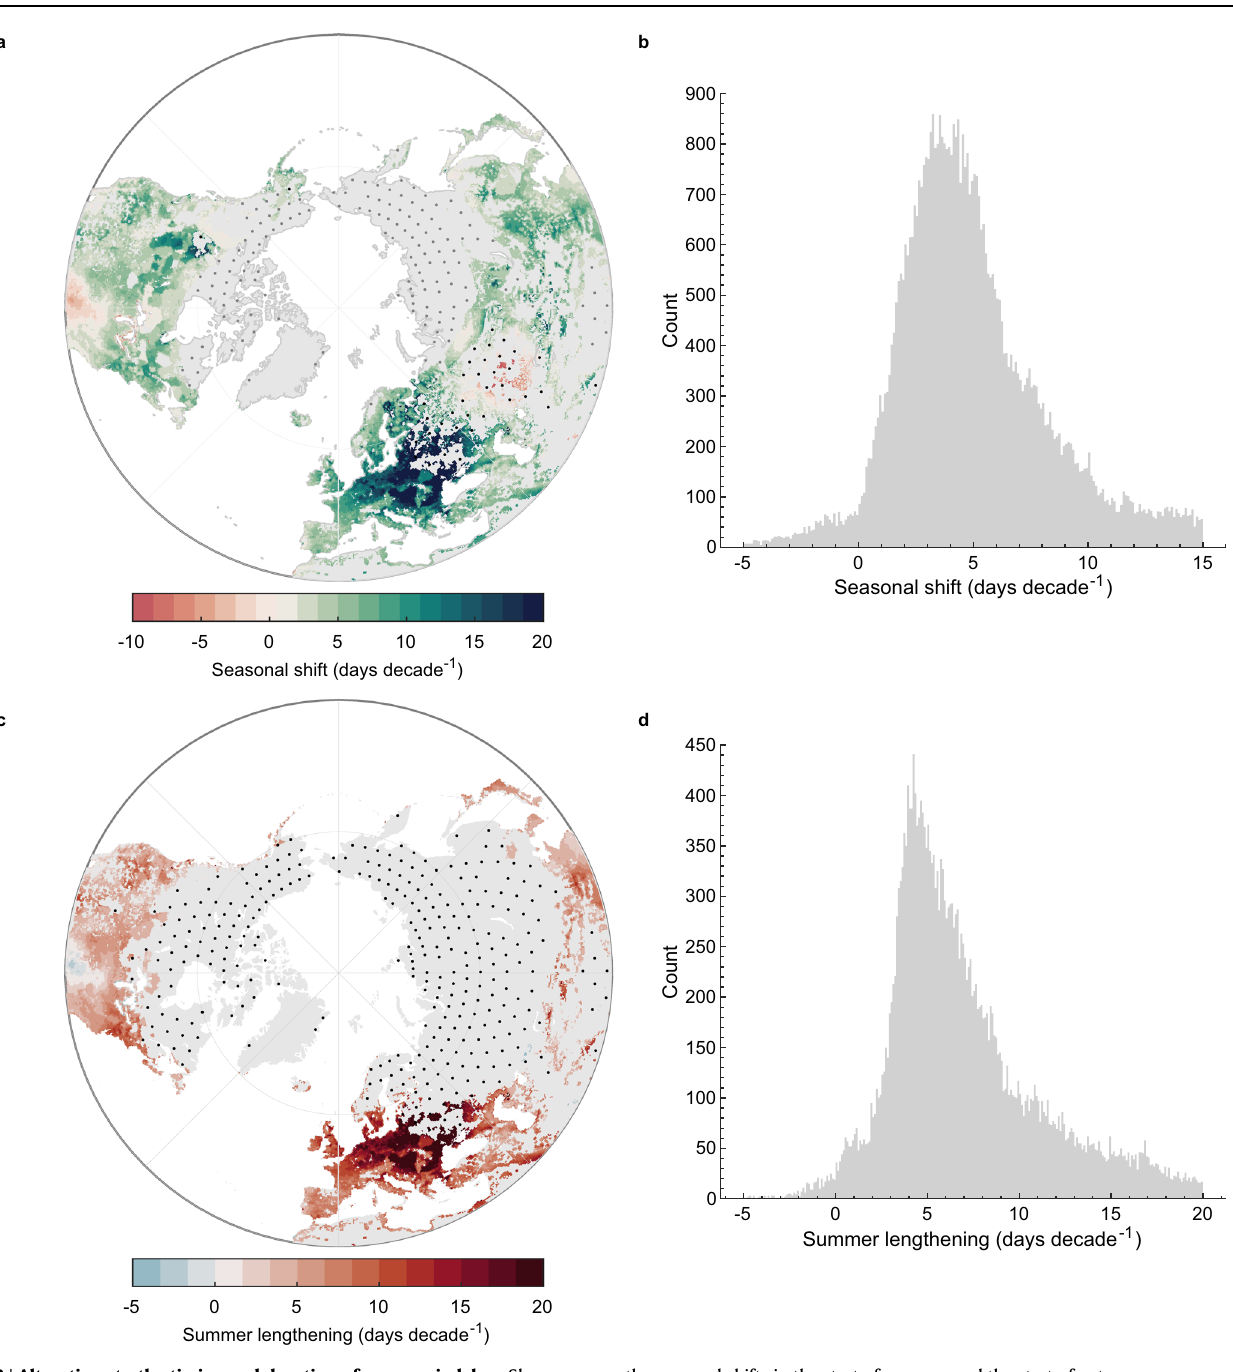
the seasonal shifts in the start of summer and the start of autumn (September – November). Positive and negative values indicate when the summer season has lengthened or shortened, respectively. Stipple markings represents regionsthatwerenotincludedintheanalysis,eitherduetothepresenceoflakeice cover(greypoints)orwhenlakesexperiencedaminimal(<0.5°Cmonth − 1 )seasonal rate of change in surface water temperature (black points) during the season of